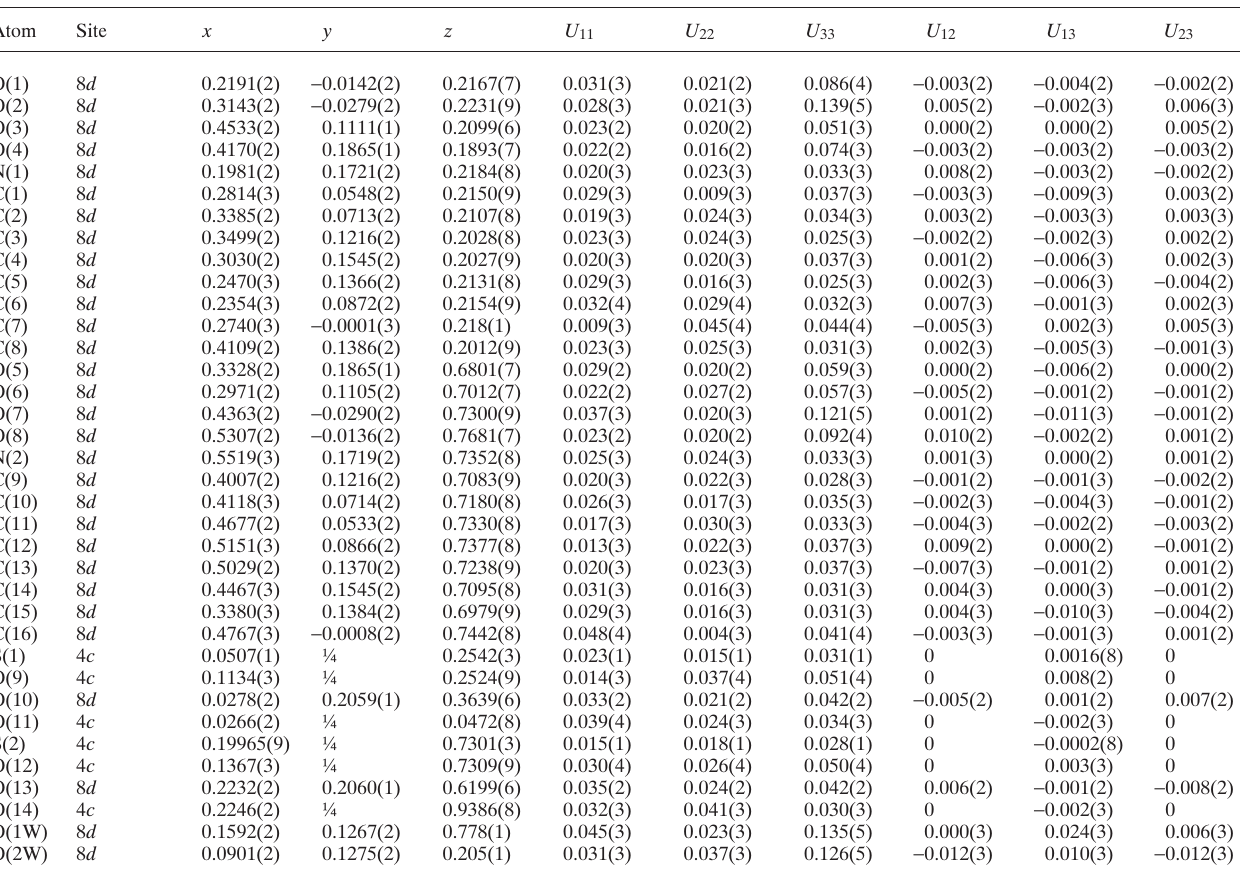
Table 3. Atomic coordinates and displacement parameters (in Å 2 ) .